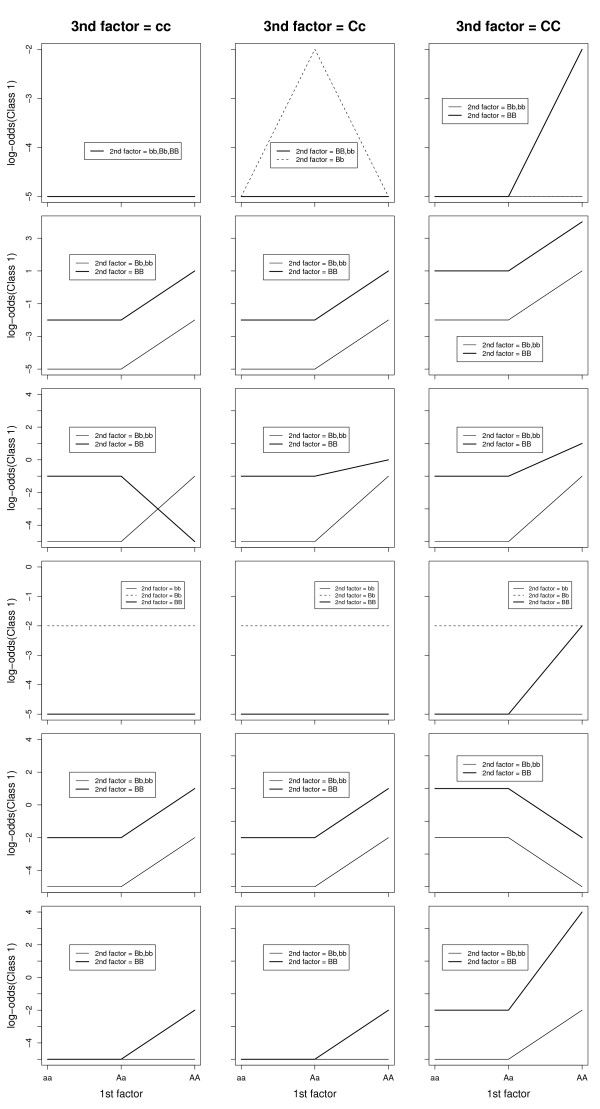
The pattern of log-odds for 3-way interaction models. The patterns of log-odds for class1(affected) for different levels of the three SNPs (SNP1, SNP2 and SNP3) under six different models with 3-way interactions. SNP1 has three levels AA, Aa, aa; SNP2 has three different levels BB, Bb, bb and SNP3 has three levels CC, Cc, cc. Each row presents a specific interaction model. The rows 1, 2, 3, 4, 5 and 6 list the interaction models Model 1, Model 2, Model 3, Model 4, Model 5 and Model 6 (Table 3) respectively.